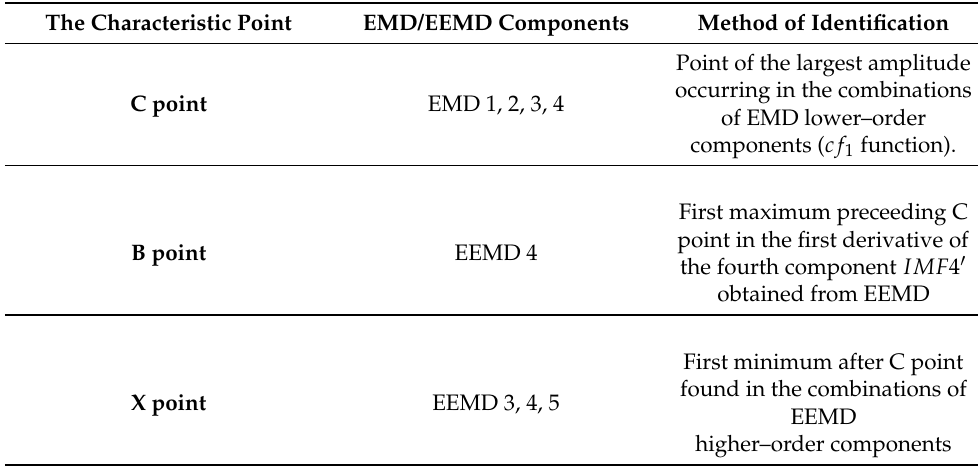
Figure 9. A flowchart illustrating the working principle of the proposed algorithm. The input data are decomposed with the EMD and EEMD methods. Then, functions cf 11 , cf 12 , IMF4’ , cf 2 of the obtained IMFs are used to find the positions of the C, B, and X points. Table 3. Methods of identifying characteristic points in the ICG